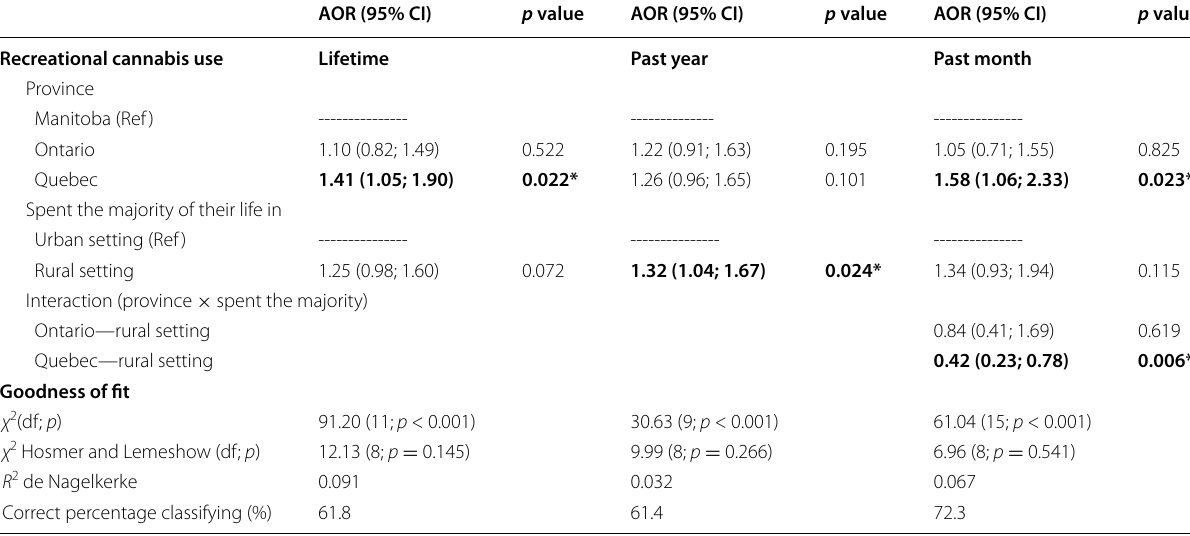
Data presented as adjusted odds ratios (with confidence interval of 95%) using logistic binary regression adjusted for sociodemographic variable (Ex. age, gender, first year of postsecondary enrollment. international/domestic students) AOR adjusted odds ratio, CI confident interval, Ref reference group * p < 0.05; ** p <